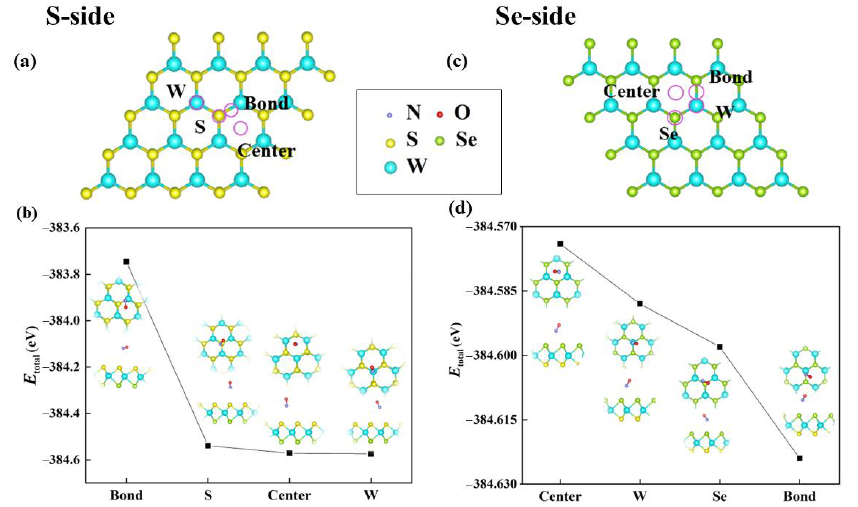
Figure 1. ( a ) S-side and ( c ) Se-side possible adsorption sites (symbolized in purple circles) considered for the case of pristine WSSe. The E total of ( b ) S-side and ( d ) Se-side NO adsorption systems with various adsorption sites. The N, O, S, Se, and W atoms are represented with the purple, red, yellow, green, and blue balls, respectively, and this color scheme is also used in Figures 2, 4, 5, 7 and 8.